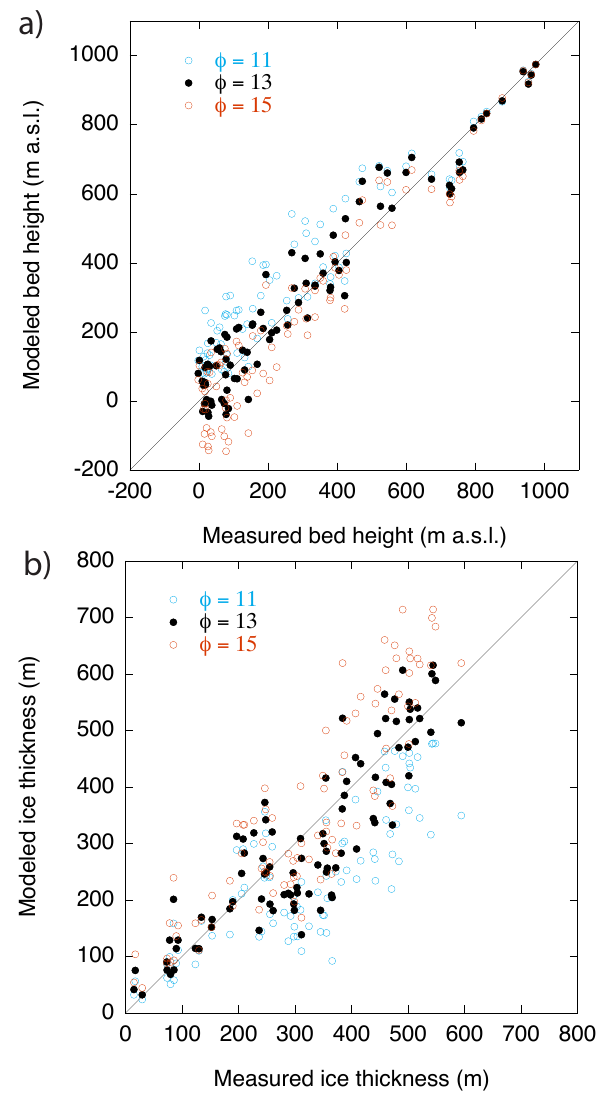
Fig. 13. Scatterplots showing the modeled bed height vs. the ob- served bed heights from radar (a) and modeled vs. measured ice thickness (b) . Results are shown for sensitivity experiments with varying material till strength. The corresponding correlation coeffi- cients, RMS misfit, bias and mean error are given in Table